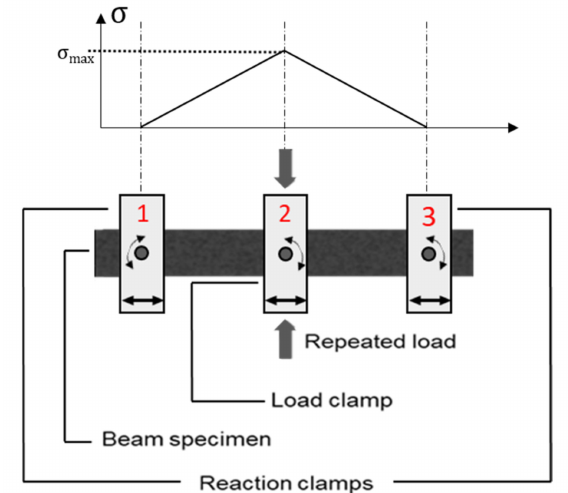
Figure 4. Schematic diagram and tensile stress distribution of 3PB fatigue